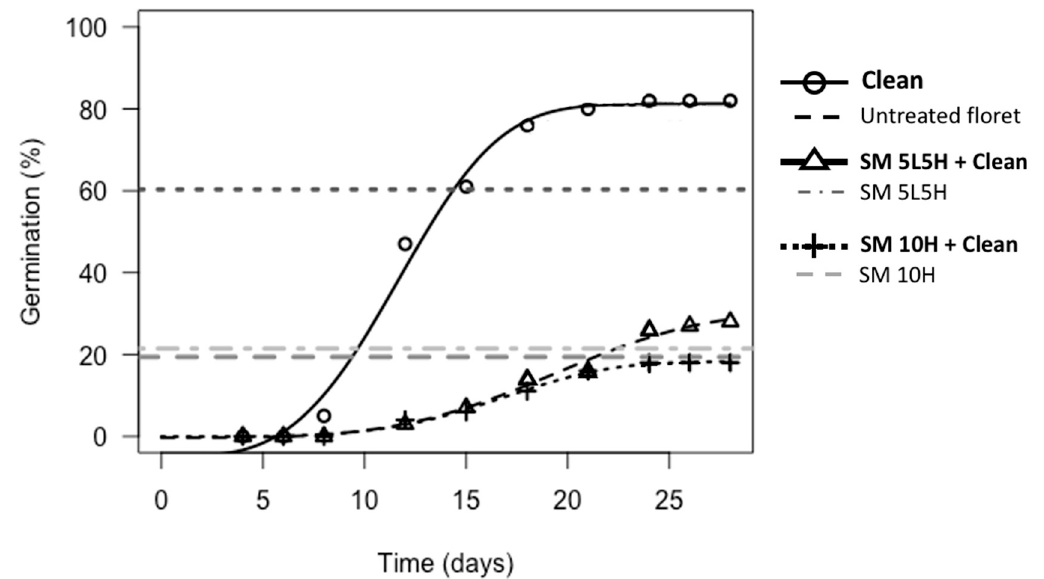
Figure 5. Germination of N. alopecuroidea untreated florets and florets flamed with the small torch with and without subsequent seed cleaning. Treatments that included seed cleaning are represented with dose-response curves, while those that did not include seed cleaning are represented by horizontal dashed lines (maximum germination at 45 d) as a comparison point. The following abbreviations are used: Clean = cleaned to seed, SM = small torch, 5L5H = exposed to a low flaming temperature for 5 min followed by a high flaming temperature for 5 min, 10H = exposed to a constant high flaming temperature for 10